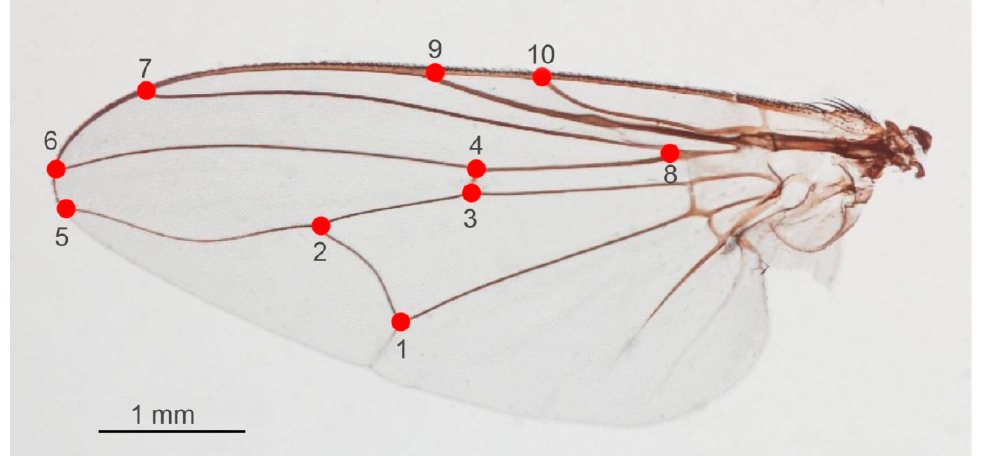
Figure 6. Ten anatomical landmarks (red dots and numbers from 1 to 10) digitized on the wing of Stomoxys flies for the landmark-based GM analysis.